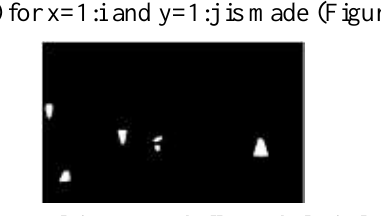
Figure 10. Applying convex hull morphological operator.